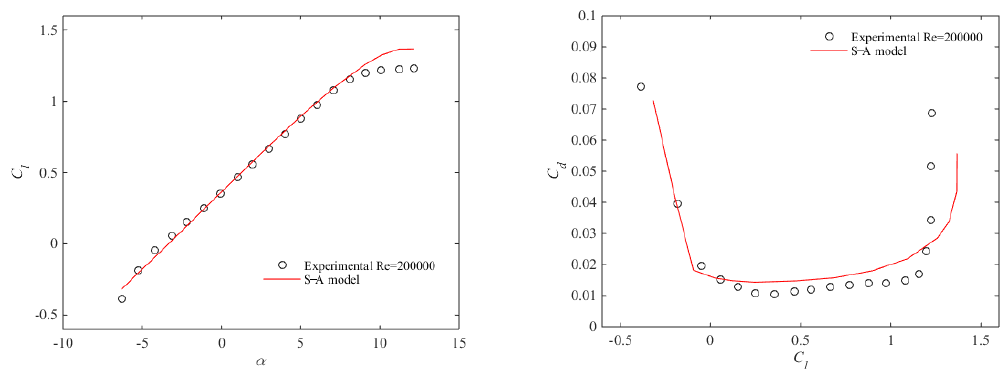
Figure 19. Lift and lift to drag polar curves of E387 airfoil at Re = 2 × 10 5 . S–A: Spalart–Allmaras model.